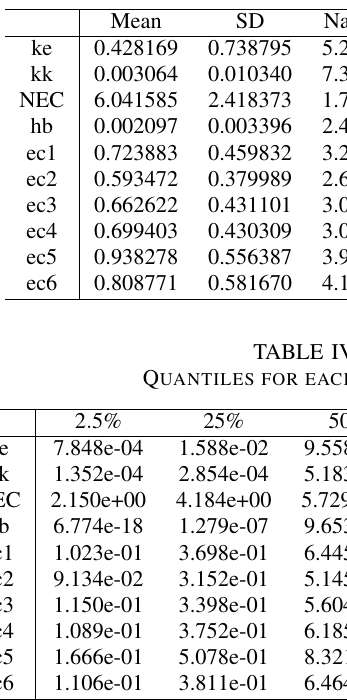
E MPIRICAL MEAN AND STANDARD DEVIATION FOR EACH VARIABLE , PLUS STANDARD ERROR OF THE MEAN .